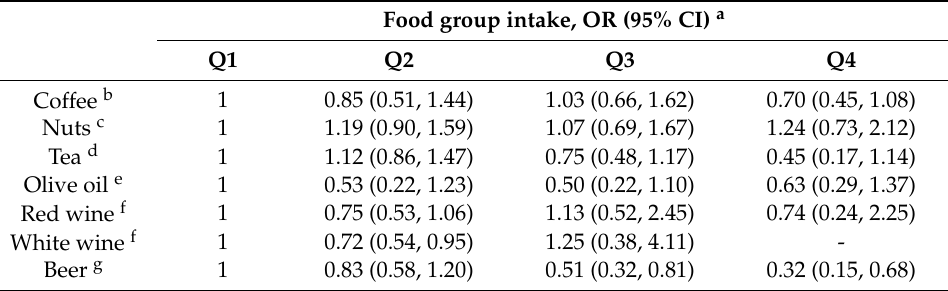
Table 3. Association between major food sources of phenolic acids and